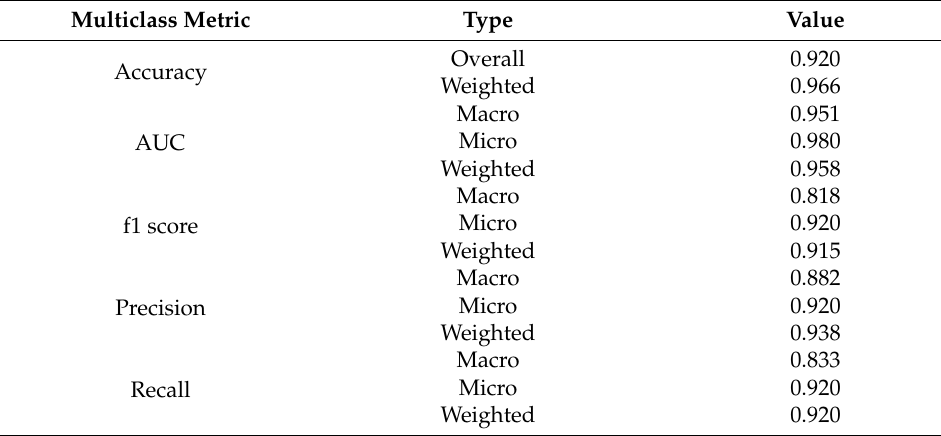
Figure 4. Classification metrics. ( a ) ROC curve, ( b ) precision – recall curve. Table 6. Multinomial classification metrics.